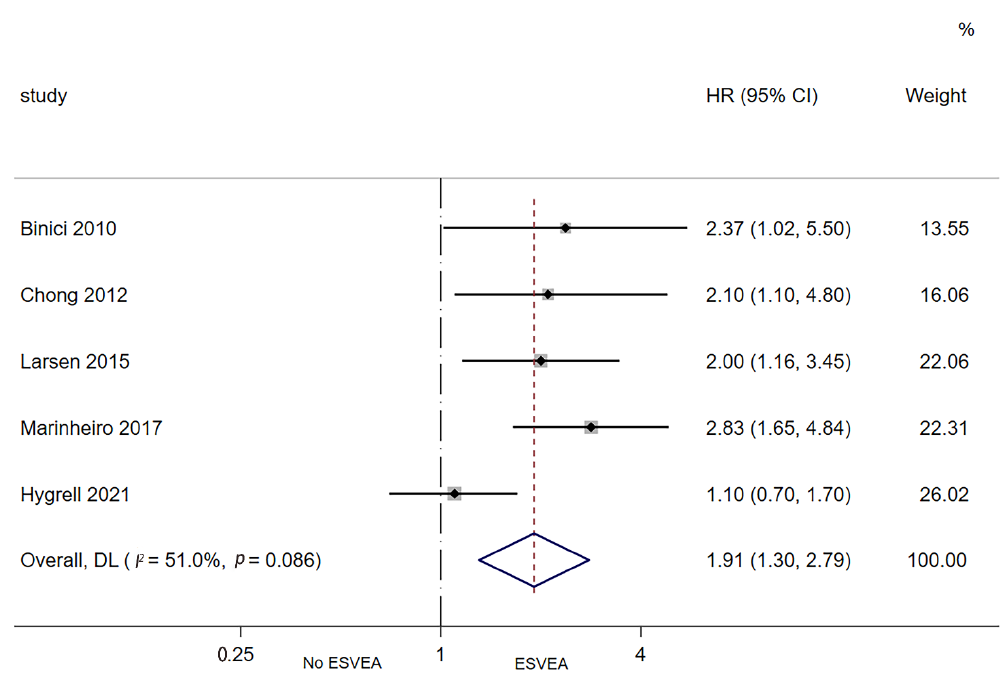
Figure 4. Forest plot of the association between ESVEA and new-onset ischemic stroke. Abbrevia- tions: ESVEA — excessive supraventricular ectopic activity; HR — hazard ratio; CI — confidence interval. [12,13,23,35,45]